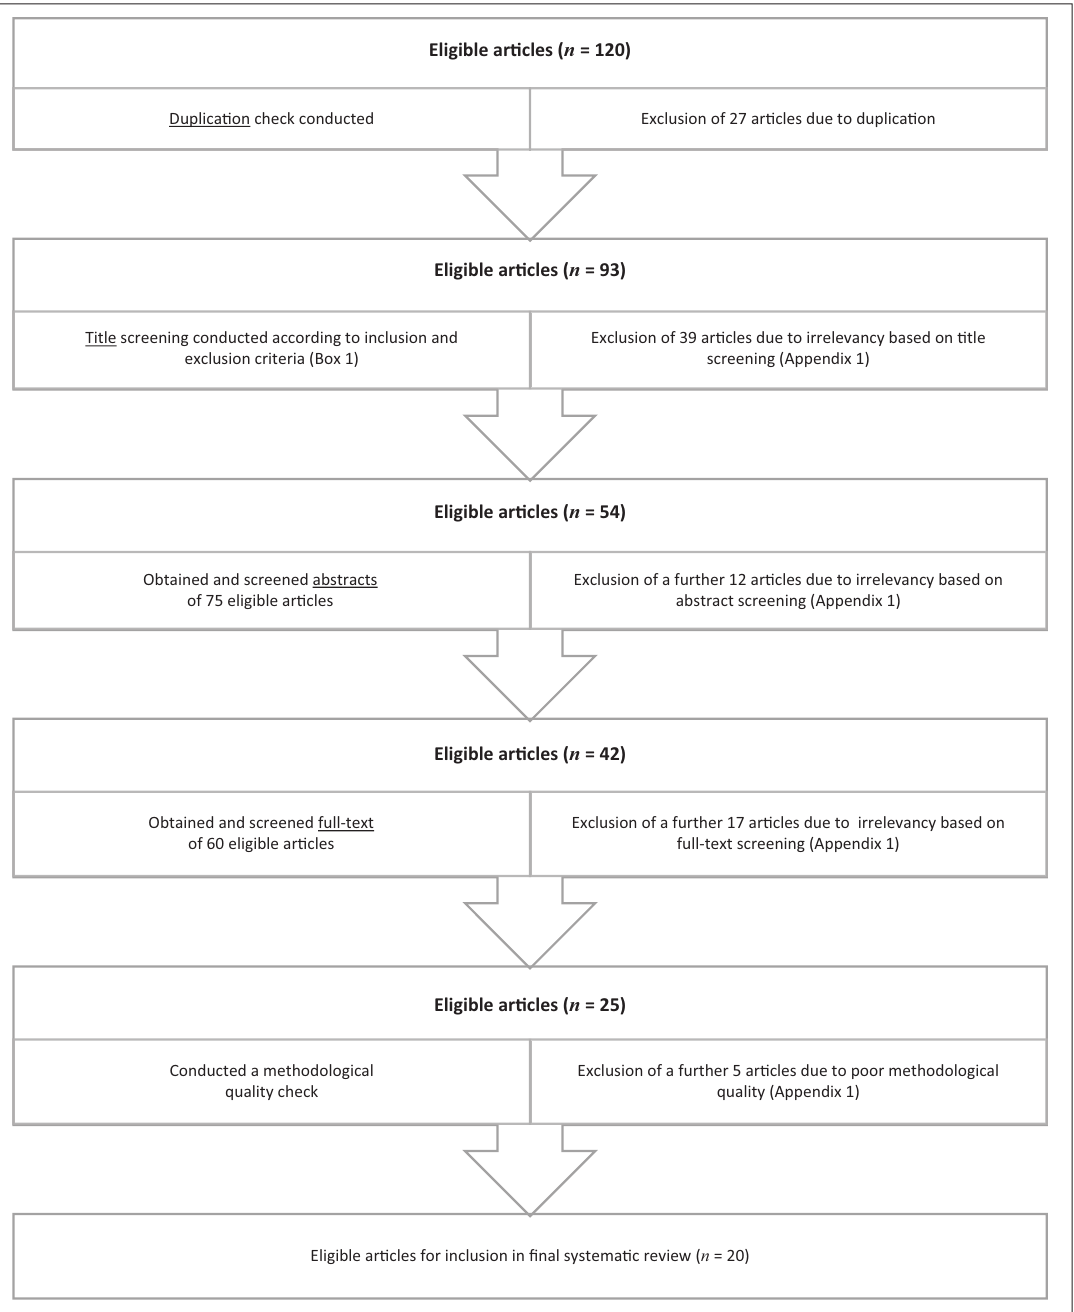
FIGURE 1: Flow diagram of search strategy to determine the final sample of the articles for the